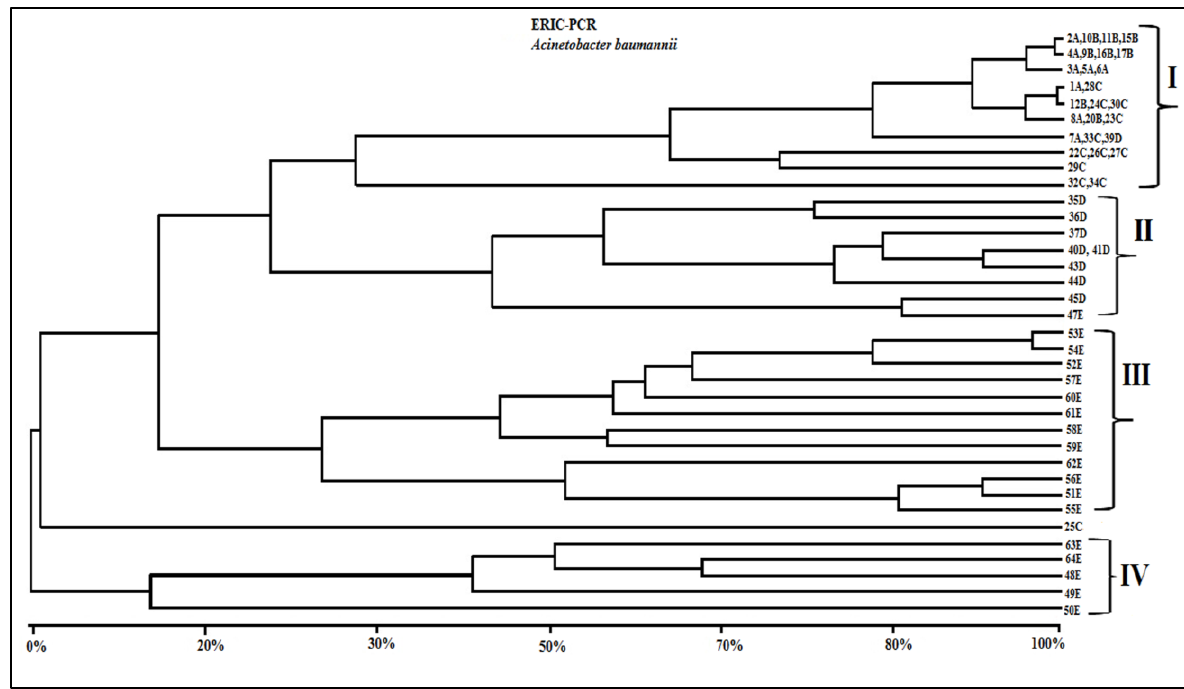
Figure 3. Dendrogram of genetic similarities showing the relationships between the analyzed A. baumannii strains (n = 55). The dendrogram was derived from DICE similarity coefficients, implemented using the NTSYS program. The construction was made using clustering with the UPGMA